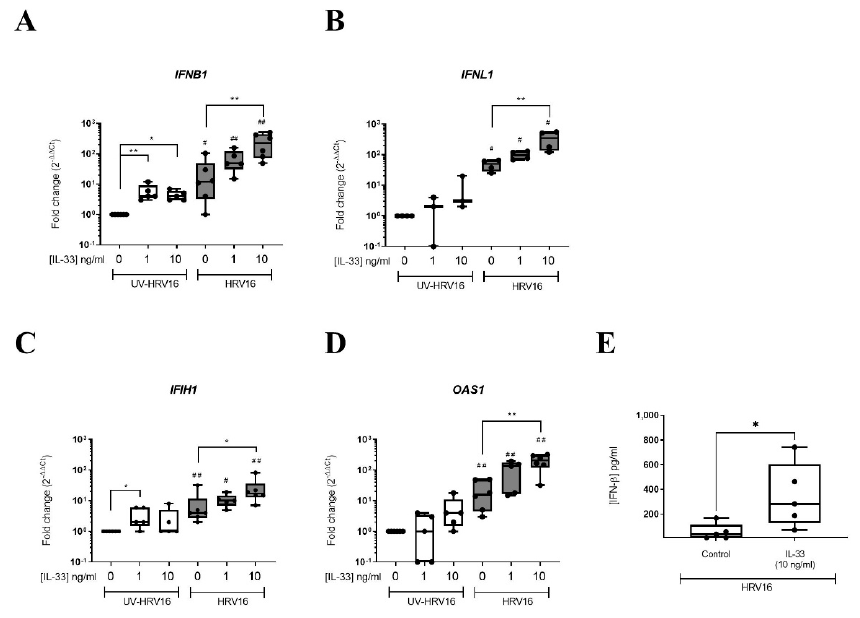
Figure 3. IL-33 enhanced HRV16-dependent anti-viral responses in MCs. mRNA expression of IFNs IFNB1 ( A ), IFNL1 ( B ) and IFN-stimulated genes IFIH1 ( C ), OAS1 ( D ) and IFN- β protein ( E ) in LAD2 MCs pretreated with or without IL-33 (1–10 ng/mL) for 24 h prior to HRV16 or UV-HRV16 (control) infection (MOI 7.5) for a further 24 h, n = 3–6. * p ≤ 0.05, ** p ≤ 0.01 for no cytokine versus IL-33 (1 or 10 ng/mL). # p ≤ 0.05, ## p ≤ 0.05 for UV-HRV16 versus